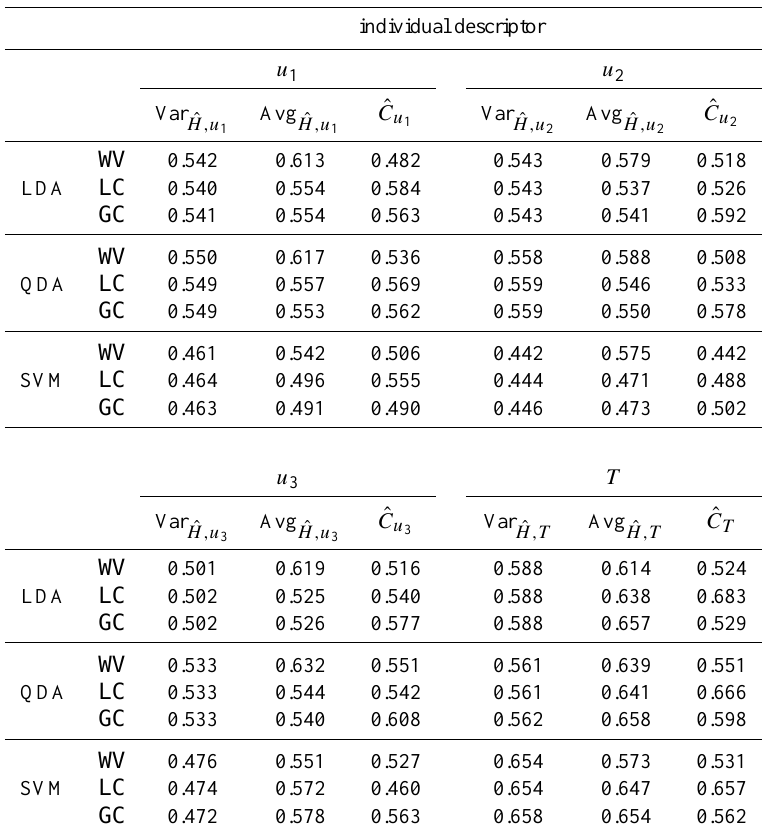
Table 4. Average correct classification rates through five thousands partitioning of the total 103 runs into training (70%) and testing (30%) sets are shown for the classification methods (LDA, QDA, SVM), the estimation methods ( WV , LC , GC ), and each individual